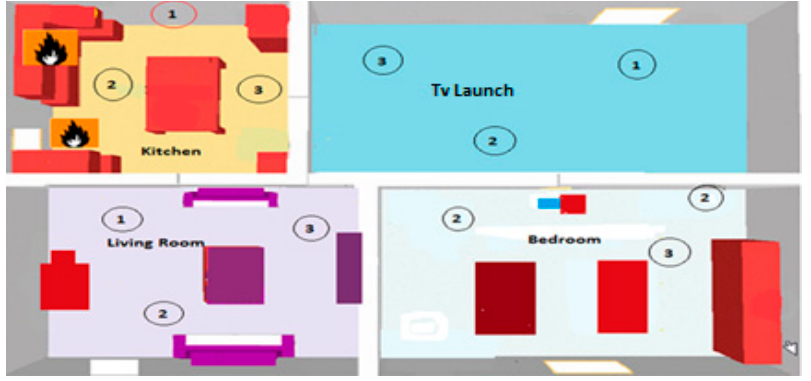
Figure 9. Indoor scenario of the simulation using FDS.